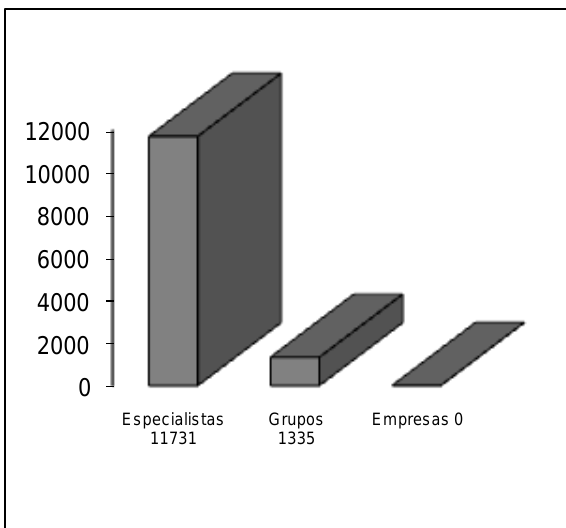
Figura 5. Educação Física: especialistas, grupos e empresas. Fonte: Portal da Inovação – Acesso em: 20/11/2008. (Figura 7), percebe-se um avanço